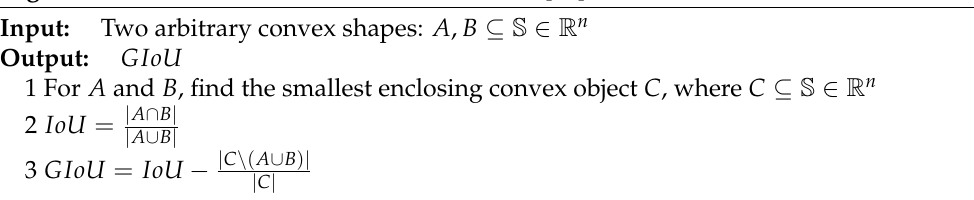
Algorithm 1 Generalized intersection over union